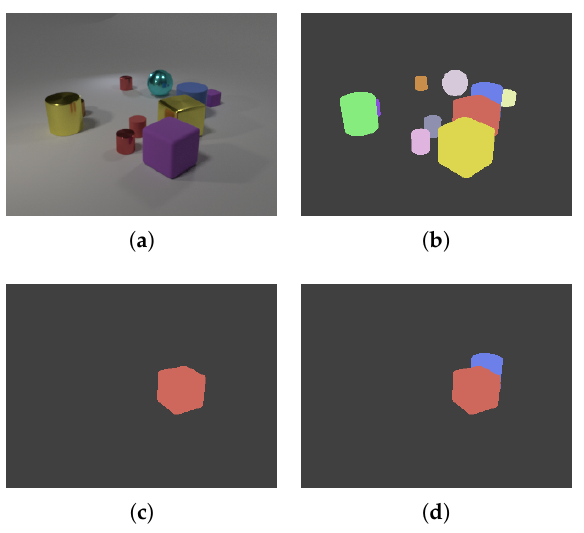
Figure 5. Example images from the CLEVR dataset; ( a ) input Image; ( b ) segmentation mask; ( c ) in- stance mask; ( d ) occlusion mask.